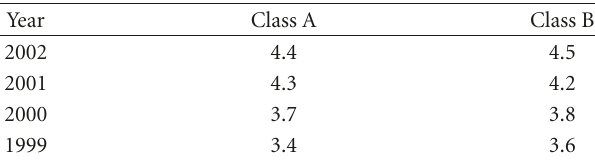
Table 4: DSP Laboratory Experiments teaching feedback survey; the average marks for the first